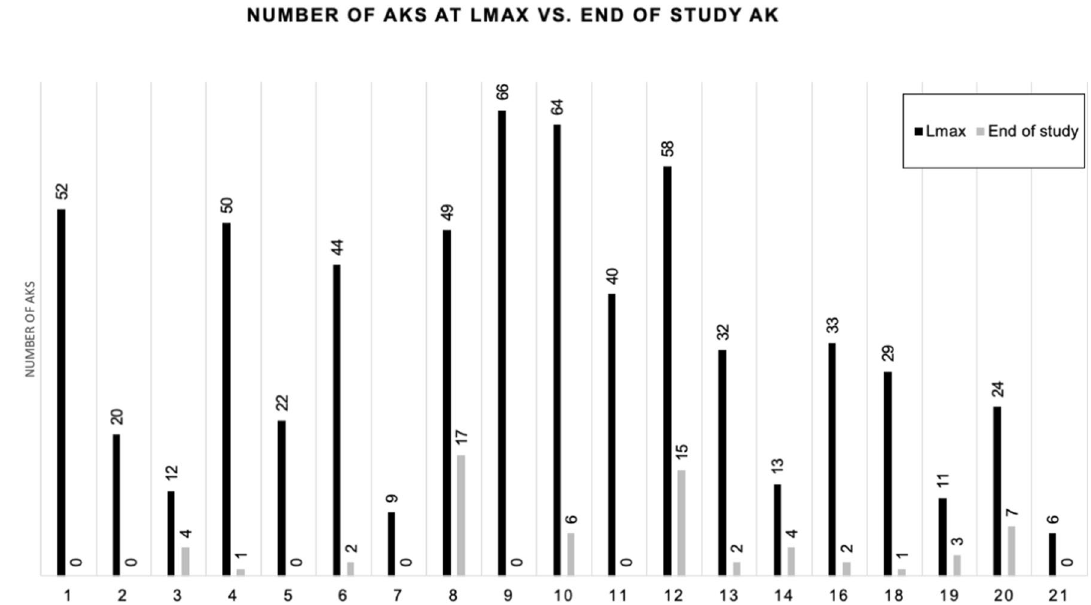
Figure 1. Comparison of maximum number of AKs (Lmax), during treatment with imiquimod (black bars) with number of AKs at week 14, two months post-treatment with imiquimod (grey bars). Numbers above bars indicate number of AKs. Patients 15 and 17 had seborrheic keratoses on initial biopsy and are excluded from this figure. The samples with both pre- and post- treatment biopsies were: 1, 4, 5, 7, 8, 9, 10, 11, 12, 13, 14, 16, 17, 18,